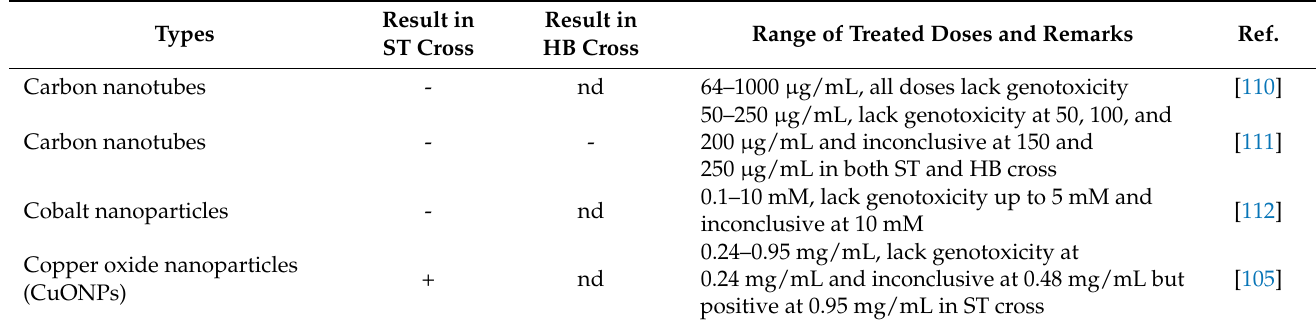
Table 6. Applications of SMART for testing